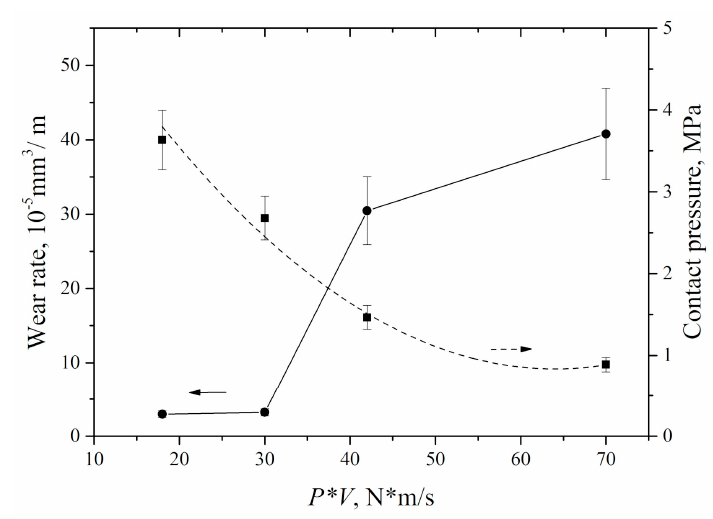
Figure 10. UHMWPE wear rate and specific pressure on the wear track vs. P · V tribological loading parameter.